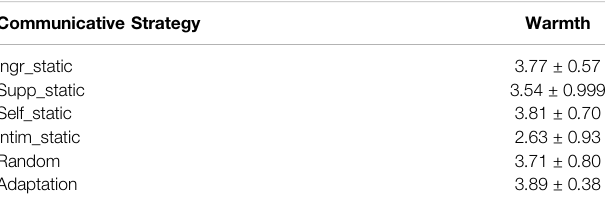
TABLE 3 | Mean and standard deviation values of competence scores for each level of Communicative Strategy. No signi fi cant differences among the conditions were